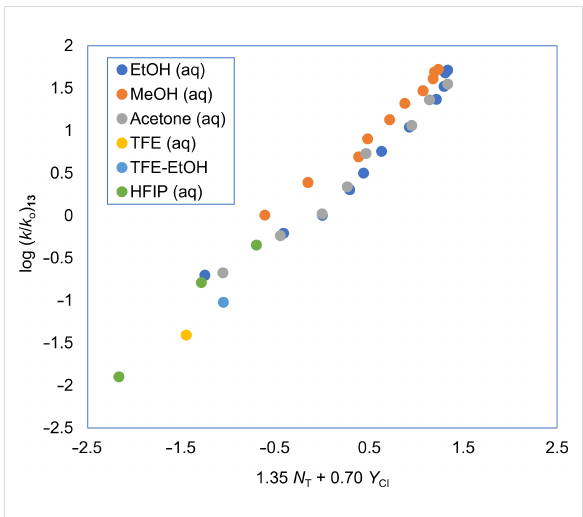
Figure 2: The S N 2 reaction plot of log ( k / k o ) vs (1.35 N T + 0.70 Y Cl ) for the solvolyses of 2-thiophenesulfonyl chloride ( 13 ) in pure and binary solvents at 25.0 °C. The specific rate values are from [56] and [62].